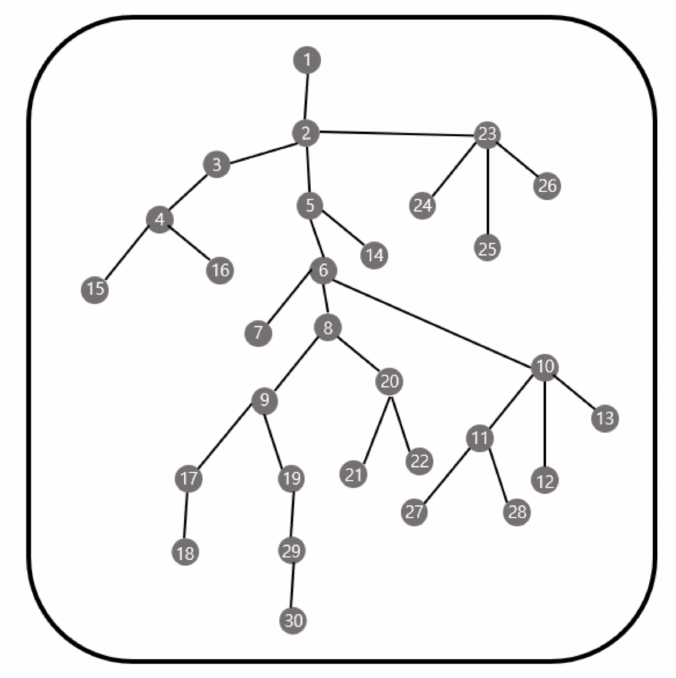
Figure 10. Topology of 30 sensor